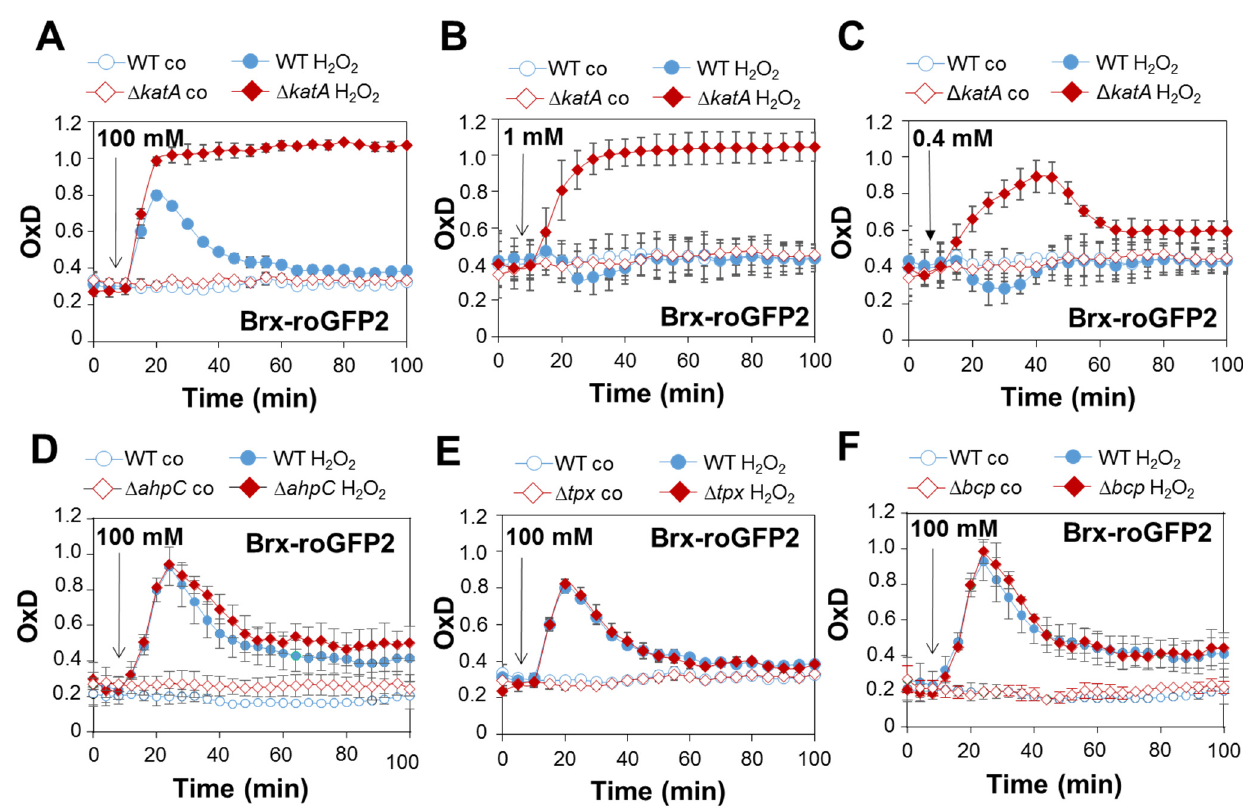
Figure 2. The Δ katA mutant can only detoxify 0.4 mM H 2 O 2 stress, as revealed by the Brx-roGFP2 biosensor in S. aureus . ( A – F ) Brx-roGFP2 biosensor responses to 100, 1 and 0.4 mM H 2 O 2 were monitored in the S. aureus COL WT, Δ katA ( A – C ), Δ ahpC ( D ), Δ tpx ( E ) and Δ bcp mutants ( F ) expressing Brx-roGFP2 from plasmid pRB473. H 2 O 2 injection assays were performed in microplates using the CLARIOstar microplate reader, as described previously [45]. The oxidation degrees (OxD) of the Brx-roGFP2 responses were calculated based on the 405/488 nm excitation ratios and normalized to fully reduced (DTT-treated) and fully oxidized (diamide-treated) controls, as described previously [45]. Mean values and SD of the OxD values are presented from three independent biological replicates.